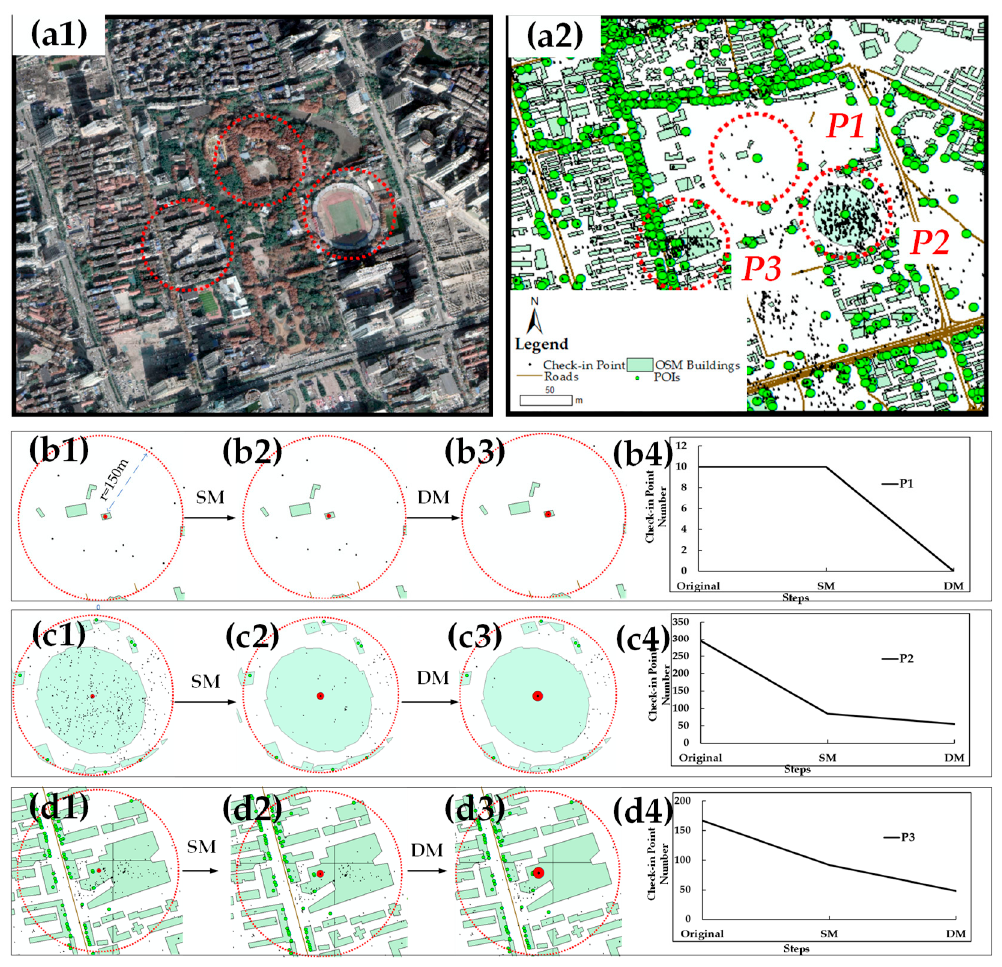
Figure 5. ( a1 , a2 ) Selected three sample regions: P1, P2, and P3. ( b1 – b4 ) Similarity matching of P1. ( c1